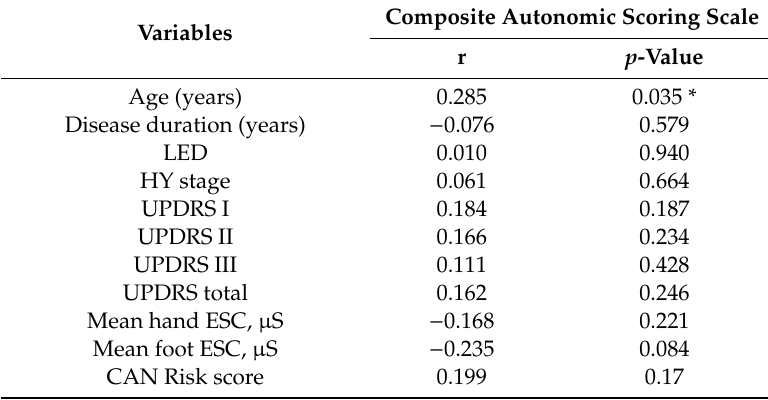
Table 4. Correlation analysis between composite autonomic scoring scale and parameters of functional outcomes and electrochemical skin